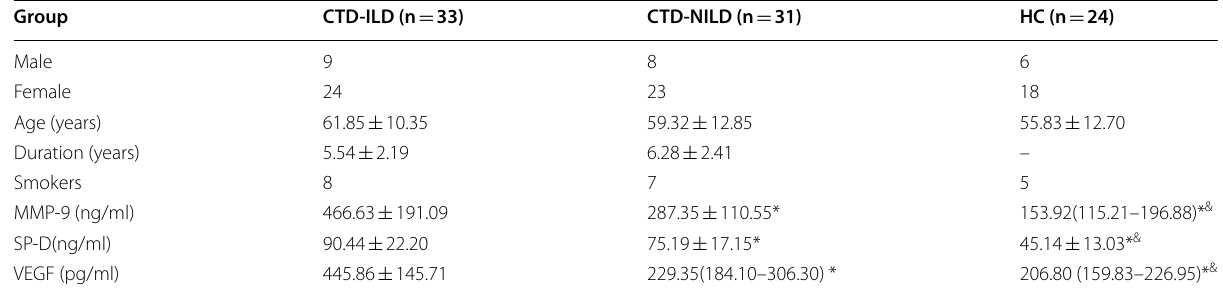
Table 1 General conditions and serum biomarkers levels in the three groups